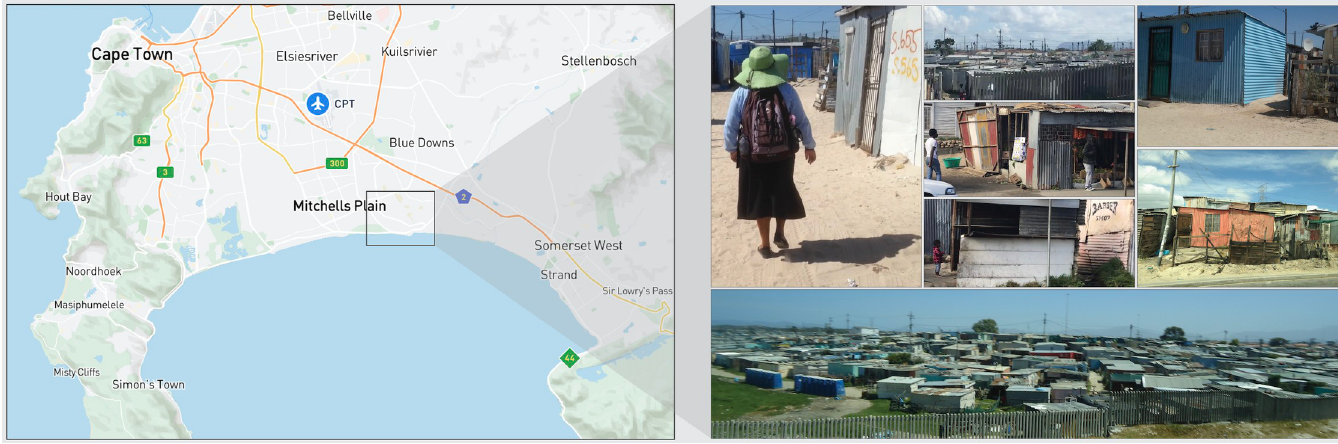
Fig 1. Philani MOVIE study setting. Left panel: map of the Western Cape Province, South Africa, (illustration by Sufian Ahmed). Right panel A: a Philani mentor mother walking between home visits. Right panel B: collage of homes and shops in Khayelitsha, South Africa. Right panel C: Bird’s eye view of Khayelitsha, a sprawing informal settlement (photos by Maya Adam). MOVIE, MObile Video Intervention for Exclusive breastfeeding.